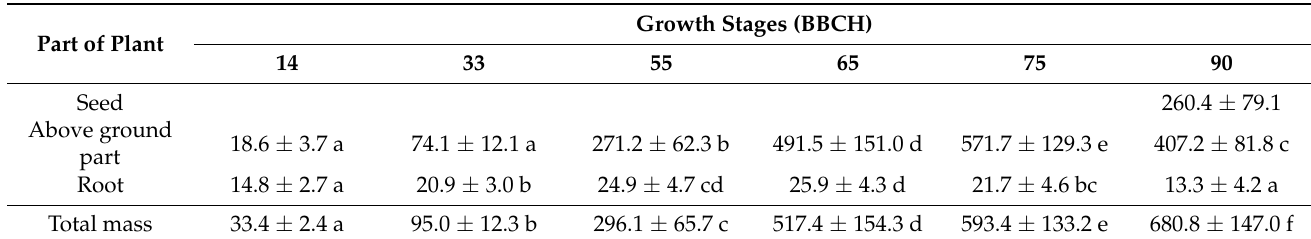
Table 4. Dry weight of pea plants in following growth stages, g · m − 2 (meanly from three replications, peas cultivars, and years of research ±